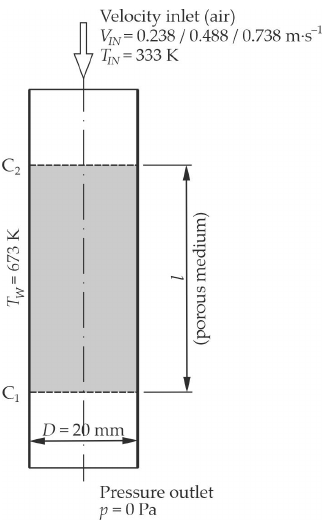
Figure 5. The geometry of the simplified fixed-bed reactor model.